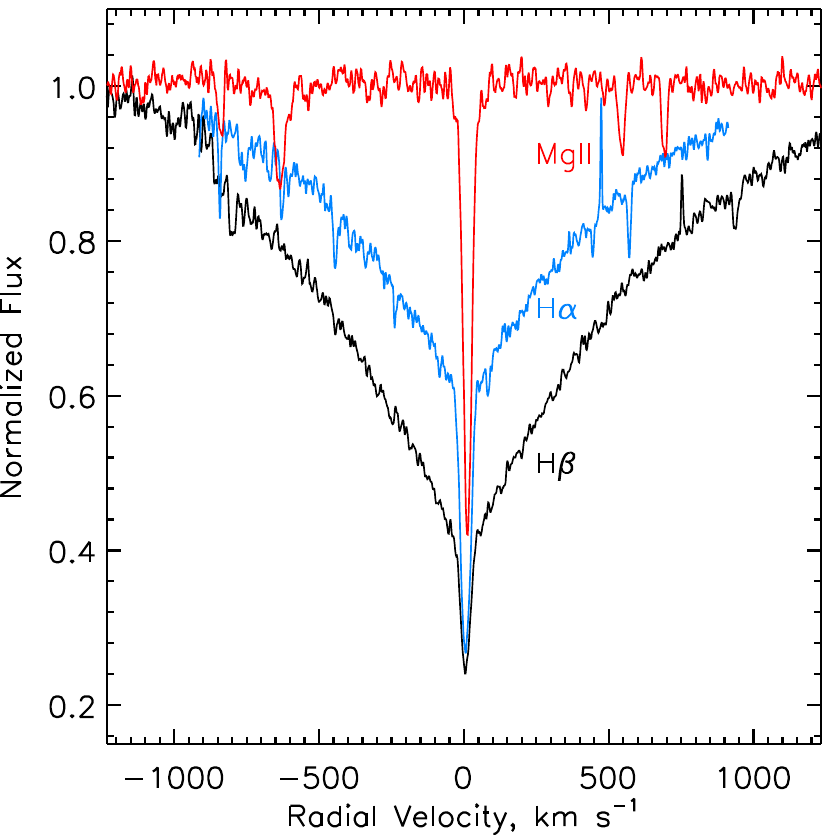
Figure 1. Comparison of broad wings hydrogen lines and narrow of MgII λ 4481 observed in the spectrum of